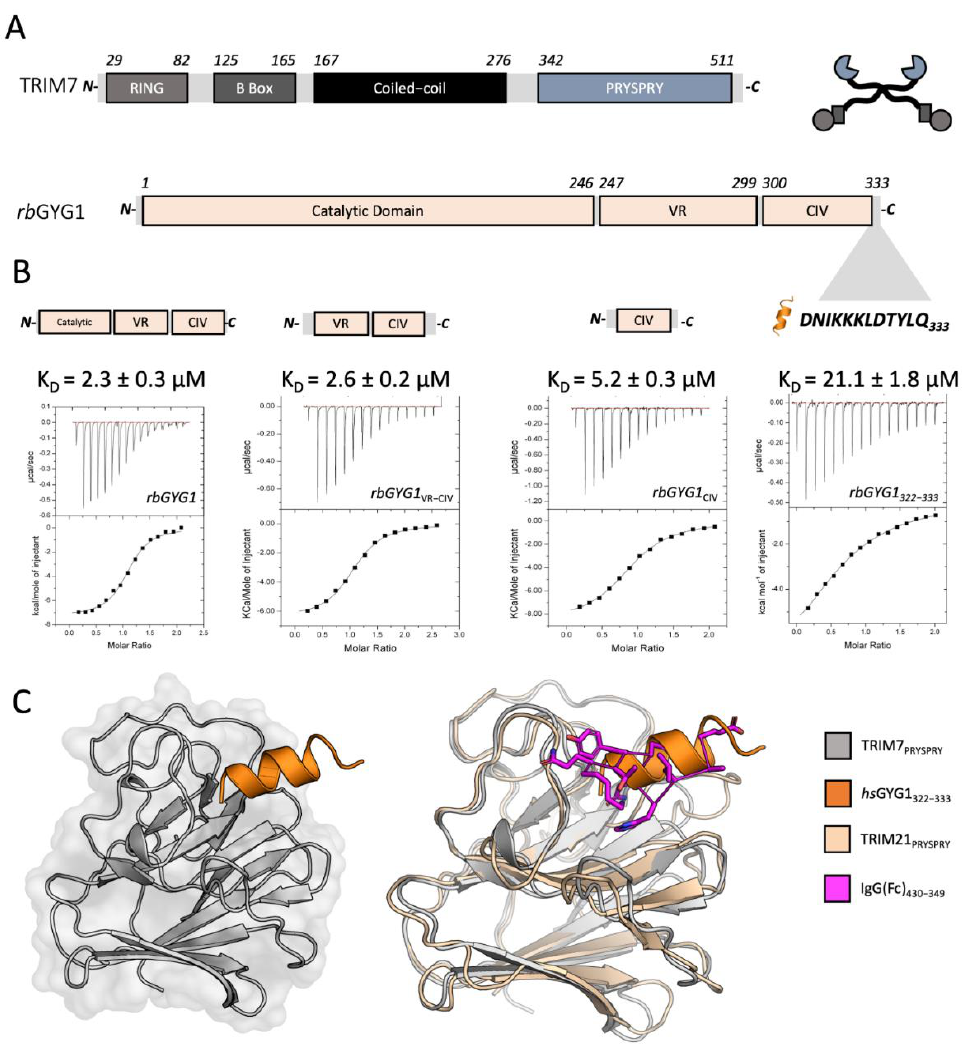
Figure 1. A linear epitope of GYG1 is sufficient to explain TRIM7 binding. ( A ) Sequence and domain organization of TRIM7 (grey) and Glycogenin1 (pale orange). TRIM7 is also depicted as a cartoon (circle—RING, rectangle—B-Box, line—Coiled-coil, cut-out circle—PRYSPRY) used throughout this paper. Highlighted are sequences determining TRIM7 binding. ( B ) ITC binding experiments with se- quential truncations of rbGYG1 (shown above each titration) titrated into human hisTRIM7-PRYSPRY. Representative traces and their accompanying fitted KD’s are shown. ( C ) Cartoon overview of the crystal structure of hisTRIM7-PRYSPRY (grey) with the GYG1 peptide (orange) on left (PDB accession 7OVX). Comparison with TRIM21:Fc structure (2IWG, PRYSPRY wheat, Fc magenta) on the